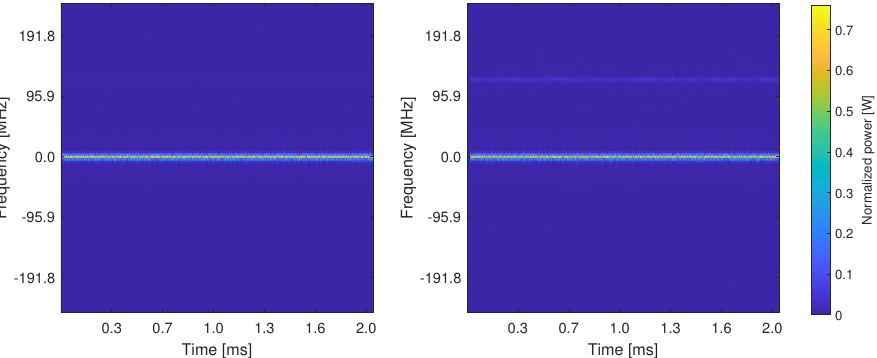
Figure 12. An example of spectrogram-based feature extraction. The left-hand figure is a spectrogram of genuine GNSS (Galileo E1) transmitter, the right-hand figure is a spectrogram of spoofer (Galileo E1)